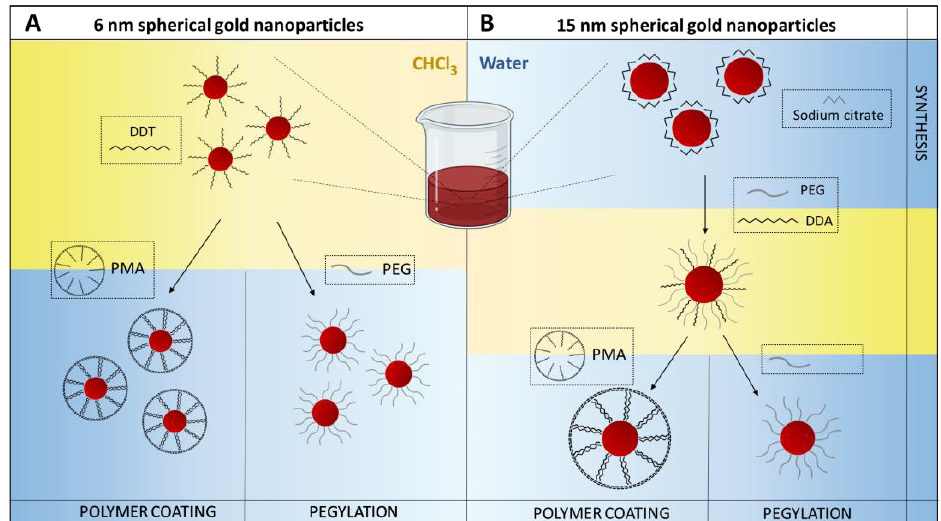
Figure 1. Steps for obtaining 6 nm ( A ) and 15 nm gold nanoparticles (GNPs) ( B ) coated with poly- (isobutylene-alt-maleic anhydride)- graft -dodecyl polymer (PMA) or polyethylene glycol (PEG). ( A) 6 nm GNPs functionalized with dodecanethiol (DDT) were synthesized in organic phase and then